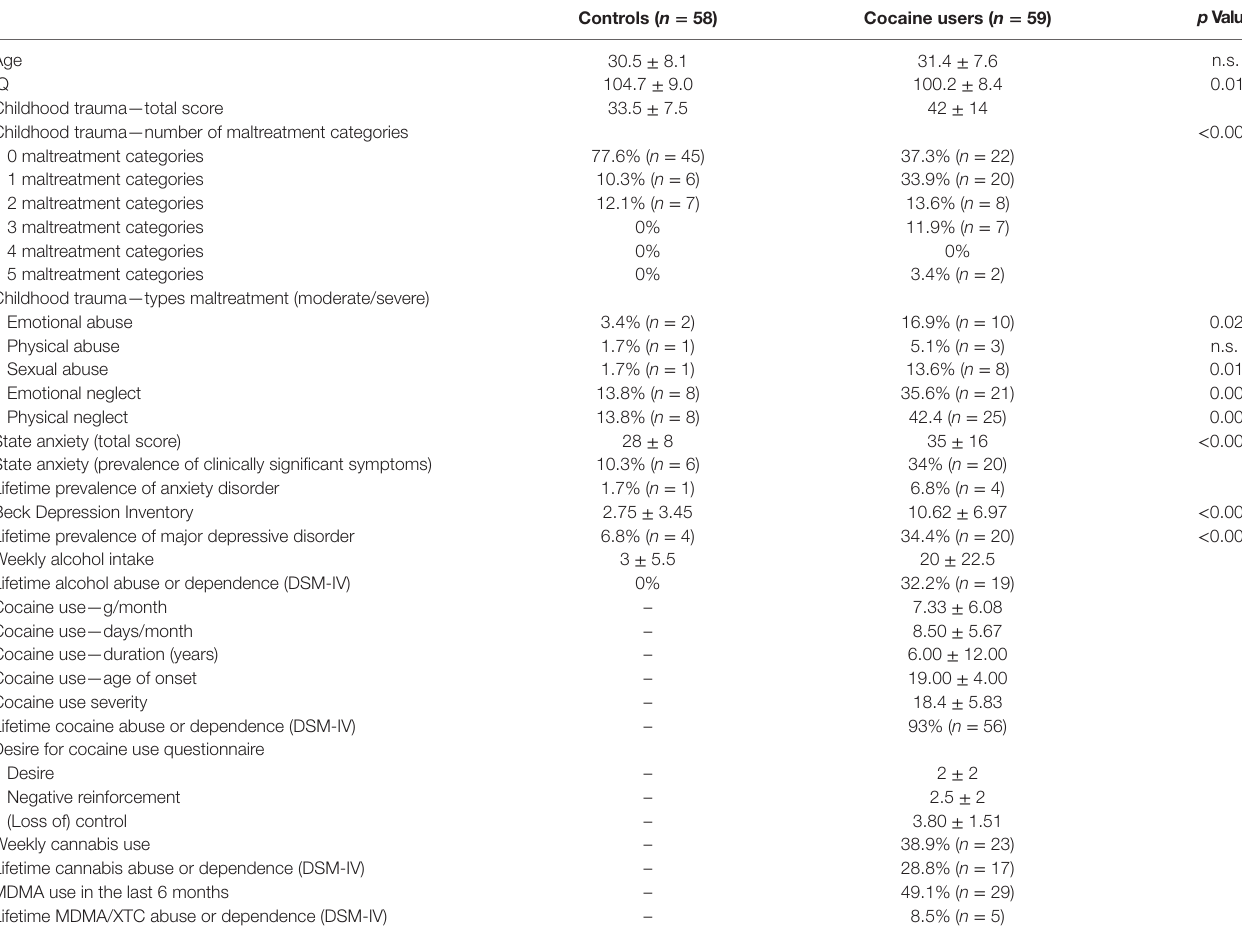
TaBle 1 | Demographic and clinical